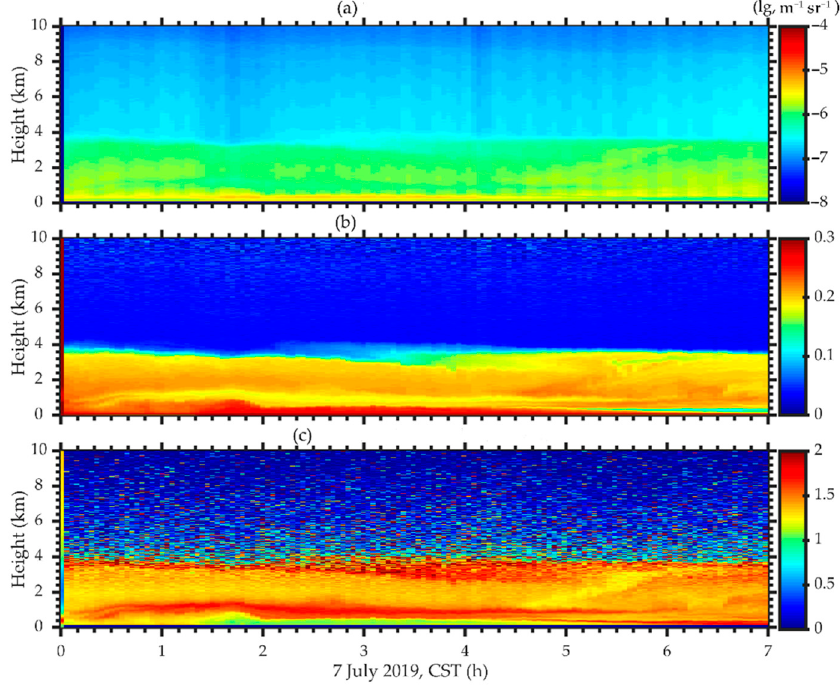
Figure 6. An overview of ( a ) TABC 532 (lg, m − 1 sr − 1 ), ( b ) VDR 532 , and ( c ) σ 532,355 = VDR 532 / VDR 355 at 00:00–07:00 on 7 July 2019.